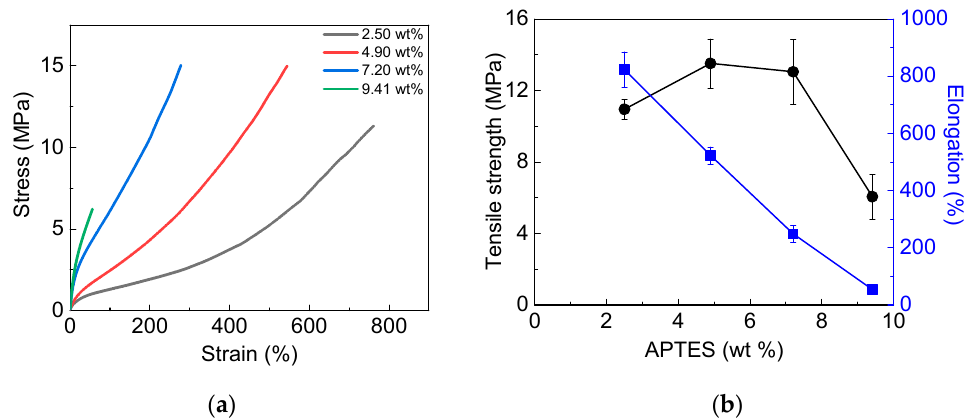
Figure 3. ( a ) Stress–strain curves and ( b ) tensile strengths ( ● ) and elongations ( ▪ ) of DSPD films with different silane contents. (DSPD having 0 wt.% of silane could not produce a standalone film due to its low T g .).